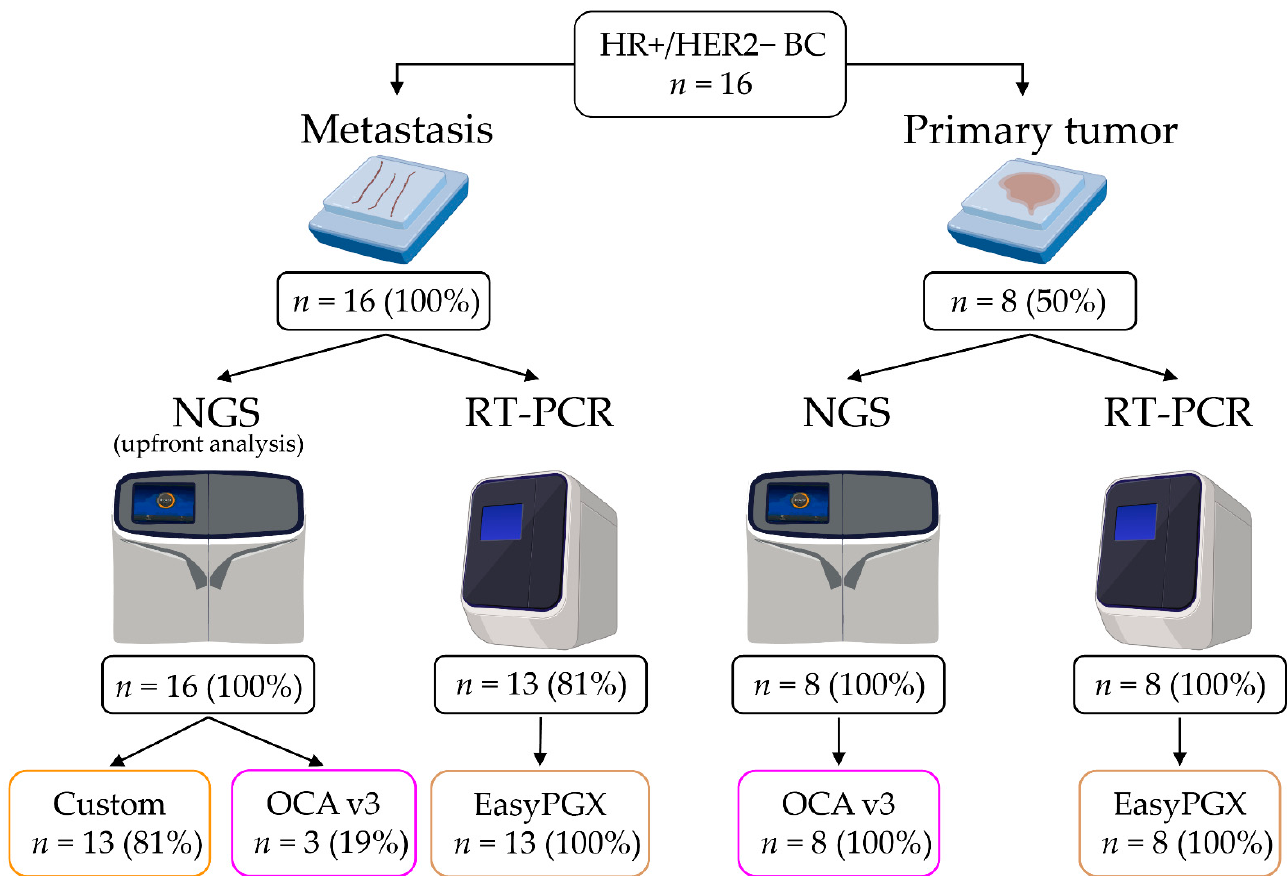
Figure 1. Study design. HR, hormone receptor; HER2, human epidermal growth factor receptor 2; BC, breast cancer; NGS, next-generation sequencing; Custom, custom panel (targeted sequencing); OCA v3, Oncomine Comprehensive Assay v3 (Thermo Fisher Scientific); EasyPGX, RT-PCR semi-closed assay (Diatech Pharmacogenetics).